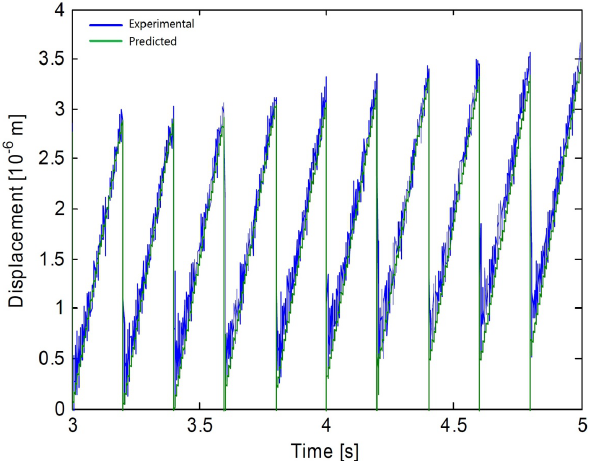
Figure 14. Experimental data and displacements predicted using Stribeck model.